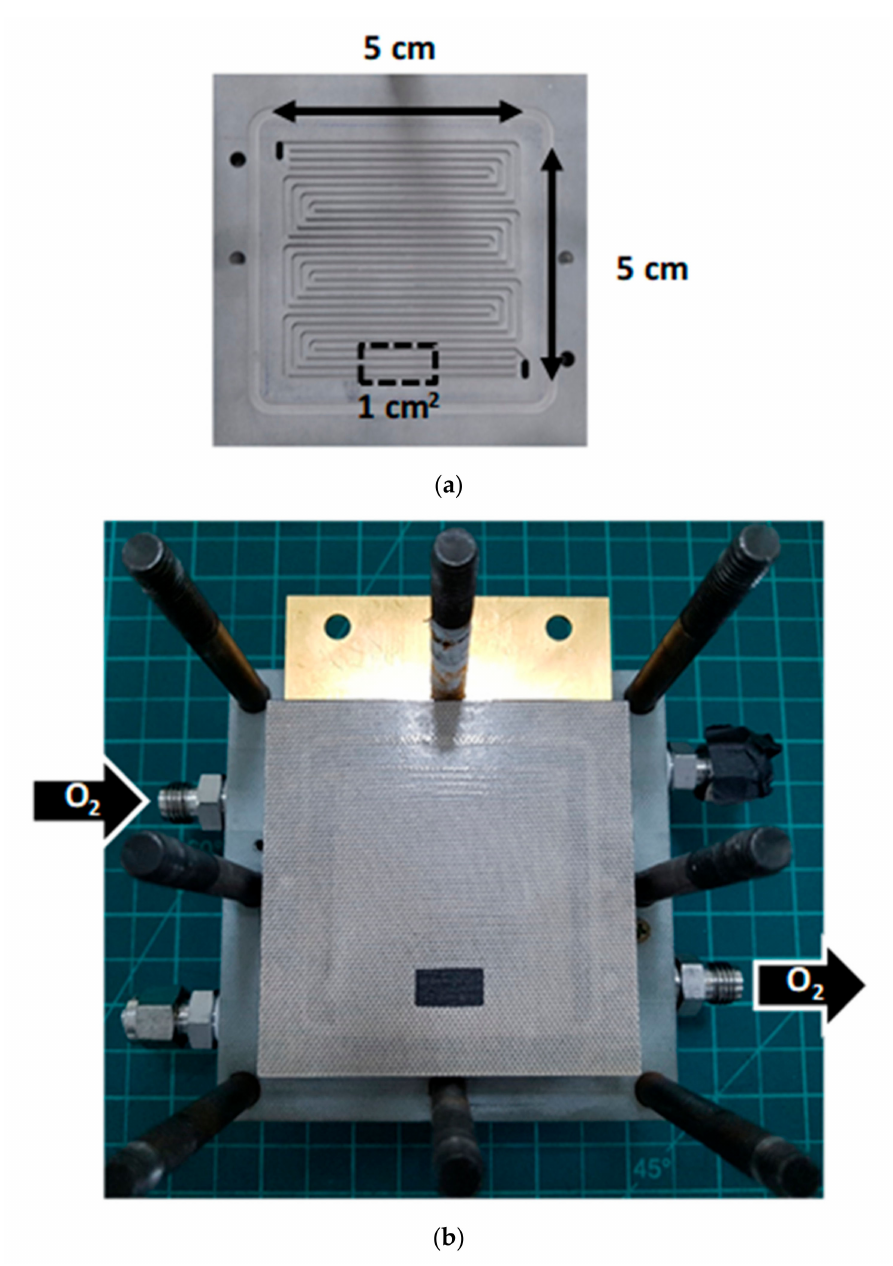
Figure 1. Setup of the active area. ( a ) Flow channel. ( b ) Assembly of end plate, flow channel, gasket, and gas diffusion layer